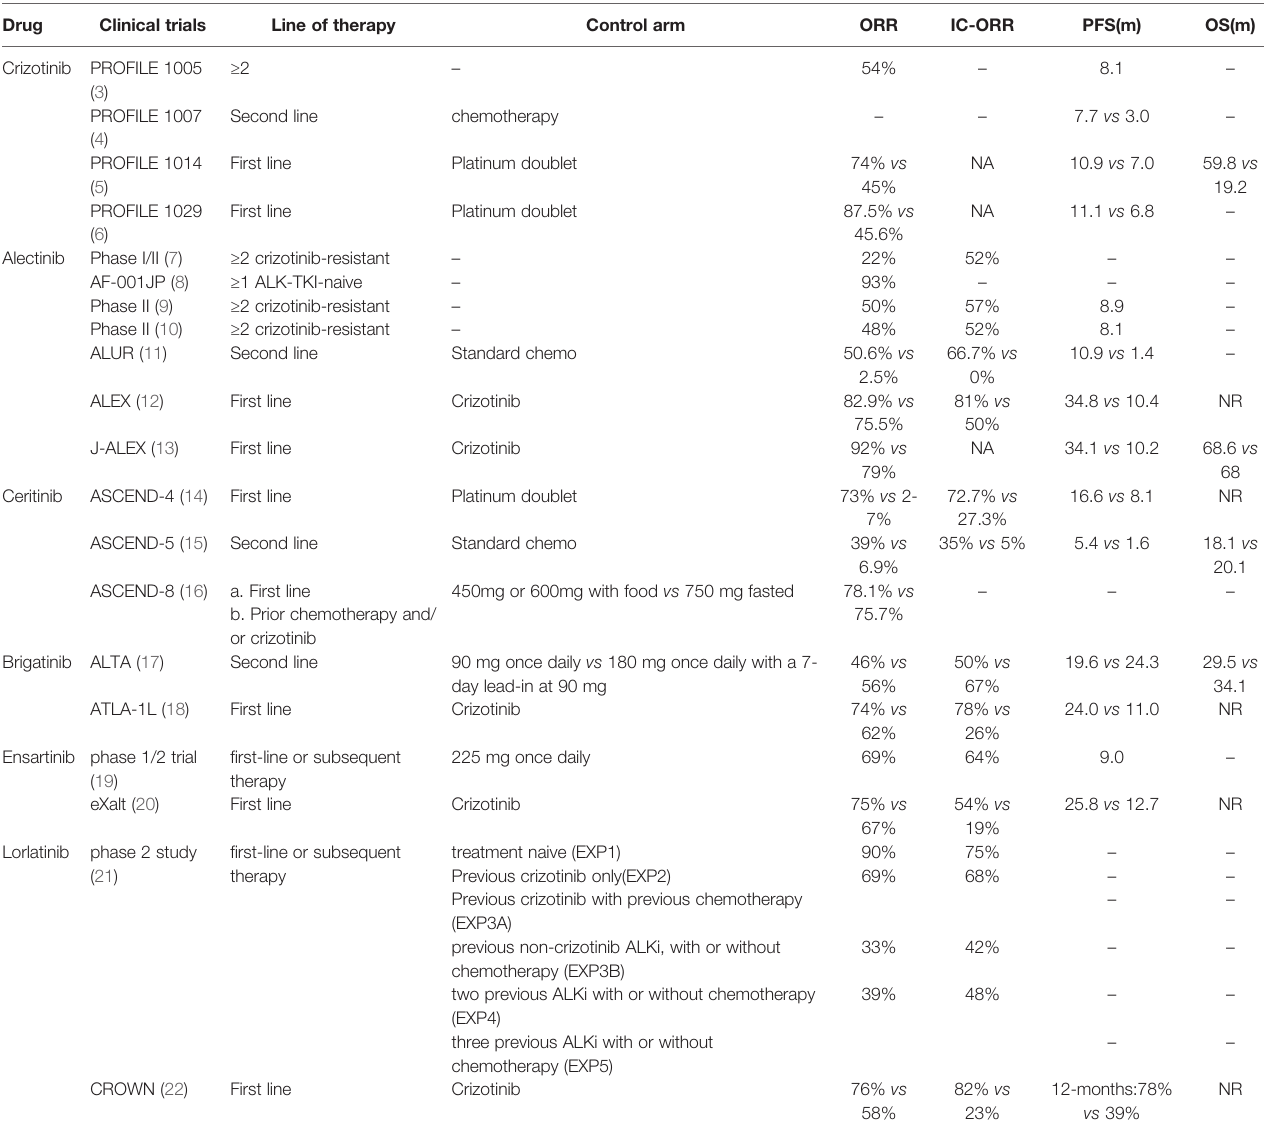
TABLE 1 | Clinical trials with anaplastic lymphoma kinase inhibitors.